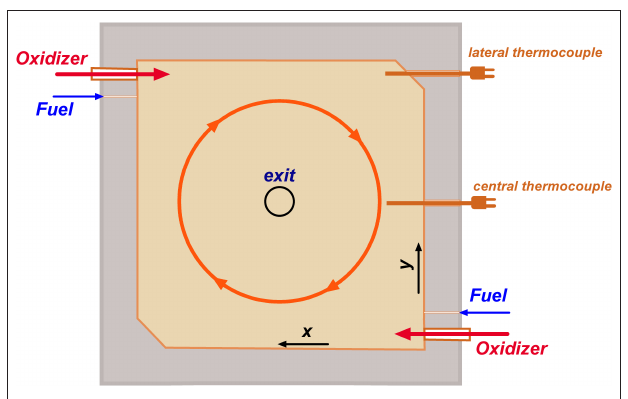
FIGURE 1 | Sketch of the midplane of the combustion chamber.